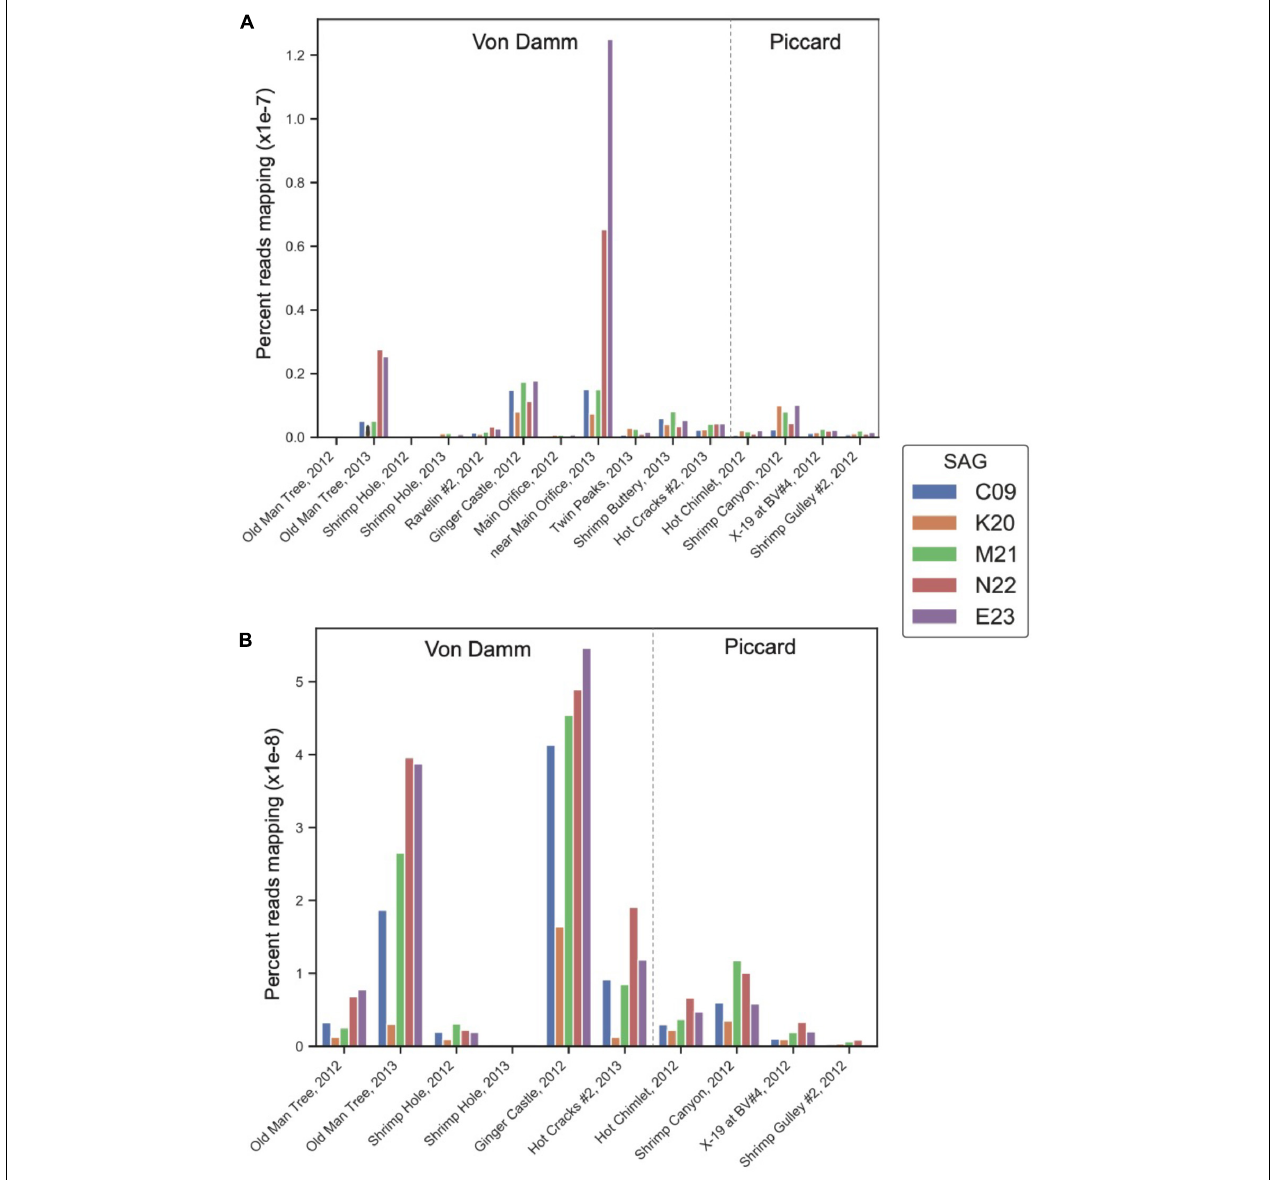
FIGURE 2 | Normalized percent mapping of (A) metagenomic reads and (B) metatranscriptomic reads for each SAG assembly. The total number of mapped reads to each SAG was divided by the number of metagenomic or metatranscriptomic reads and by total SAG length. Supplementary Table 1 lists all samples used for